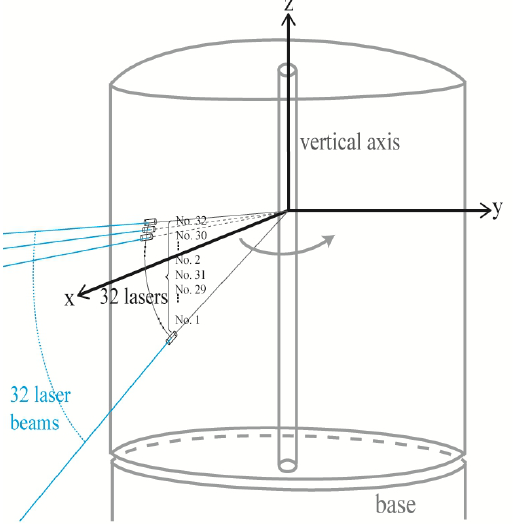
Figure 1. Postulated Velodyne HDL-32E’s configuration According to the user manual (Velodyne, 2013), the mathematical model of the HDL-32E for point i captured by